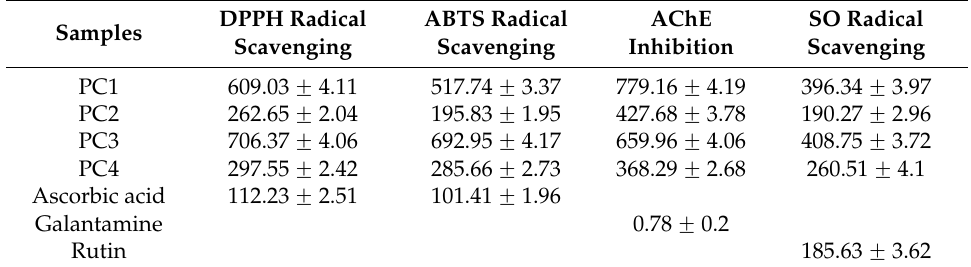
Table 1. IC 50 ( µ g/g) values of different persimmon cultivar seeds extract and positive